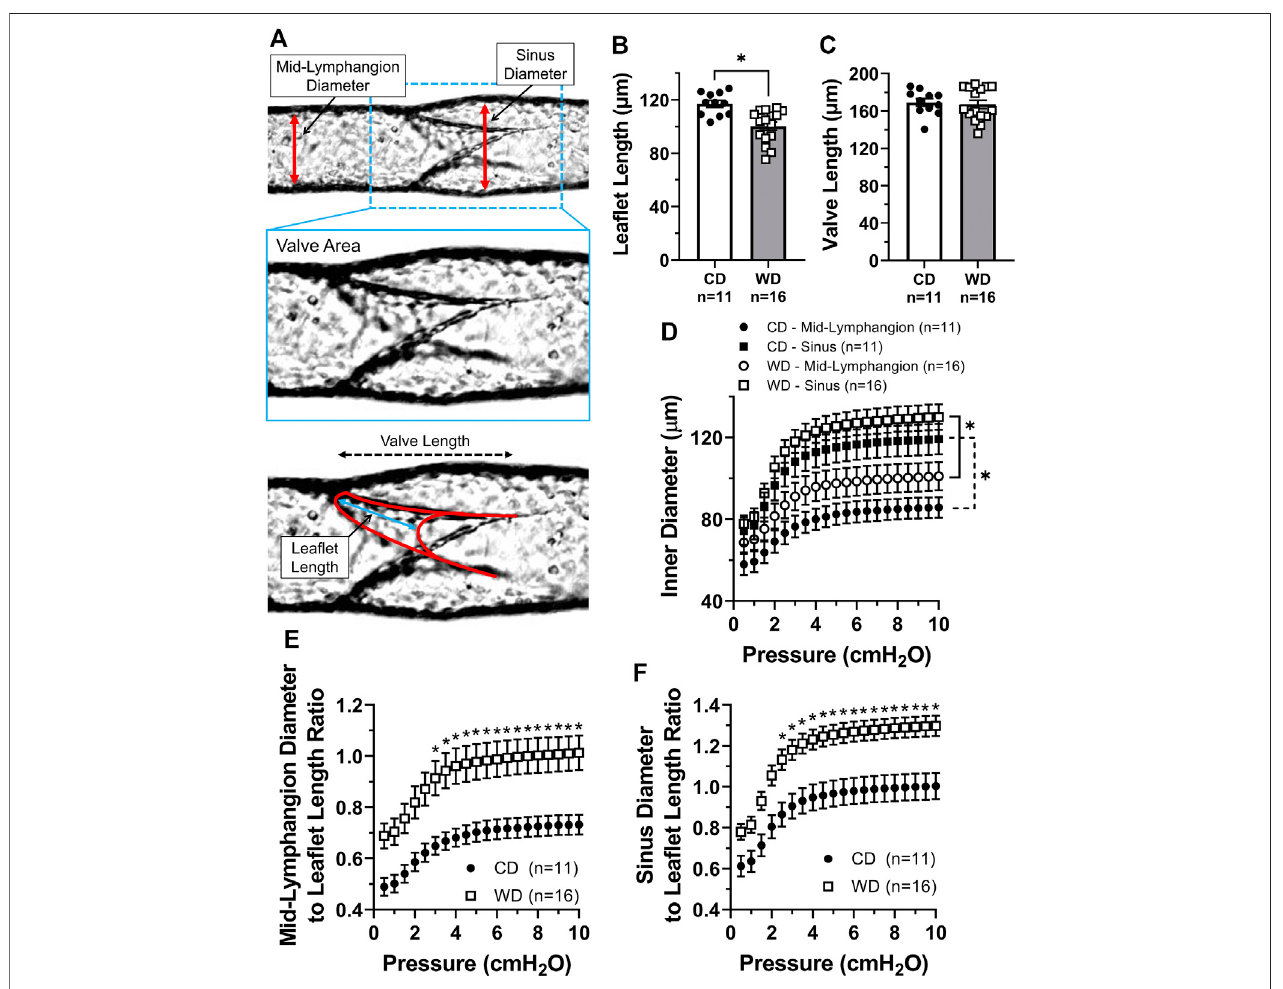
FIGURE 3 | Increased lymphatic vessel diameter to lea fl et length ratios in western diet fed mice. (A) Diagram displaying the different parameters measured to assess morphological changes in lymphatic vessels and valves induced by obesity; (B) lea fl et length; (C) valve length; (D) mean inner diameter, measured at mid- lymphangion and sinus areas, as a function of intraluminal pressure; (E) ratio between the mid-lymphangion vessel diameter and lea fl et length as a function of pressure; and (F) ratio between the sinus diameter and lea fl et length as a function of pressure. Data is presented as mean ± SEM. Statistically signi fi cant differences